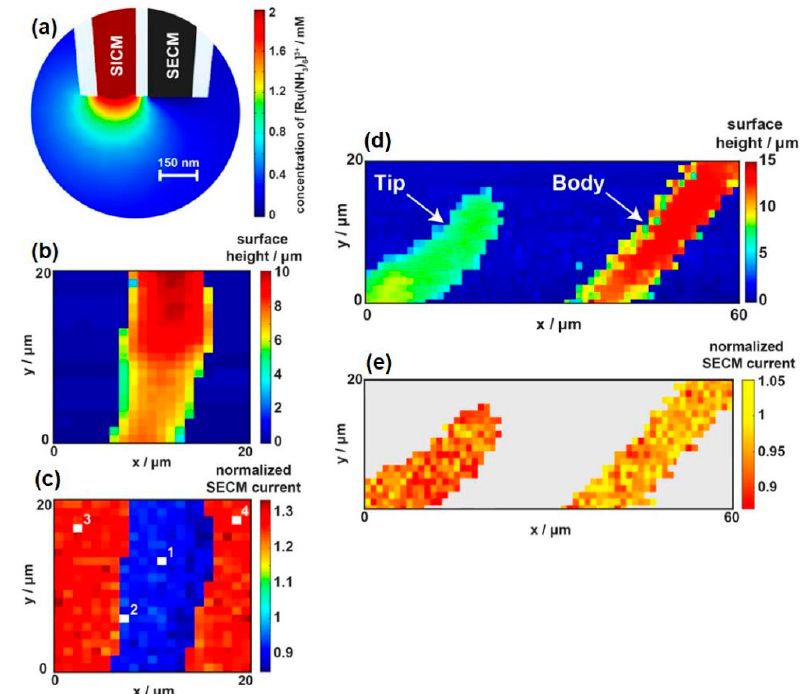
Figure 14. ( a ) Finite element method modeling of the SICM-SECM uptake system; ( b ) Substrate topography extracted from the z-position at the point of closest approach; ( c ) Normalized SECM current map showing the difference in uptake between glass substrate (zero uptake) and the root hair cell; ( d ) Substrate topography extracted from the z-position at the point of closest approach from the SICM channel; ( e ) Normalized SECM current map showing a clear difference in uptake between the root hair cell body (higher current, lower uptake) and the root hair cell tip (lower current, higher uptake). Copyright (2017) American Chemical Society.